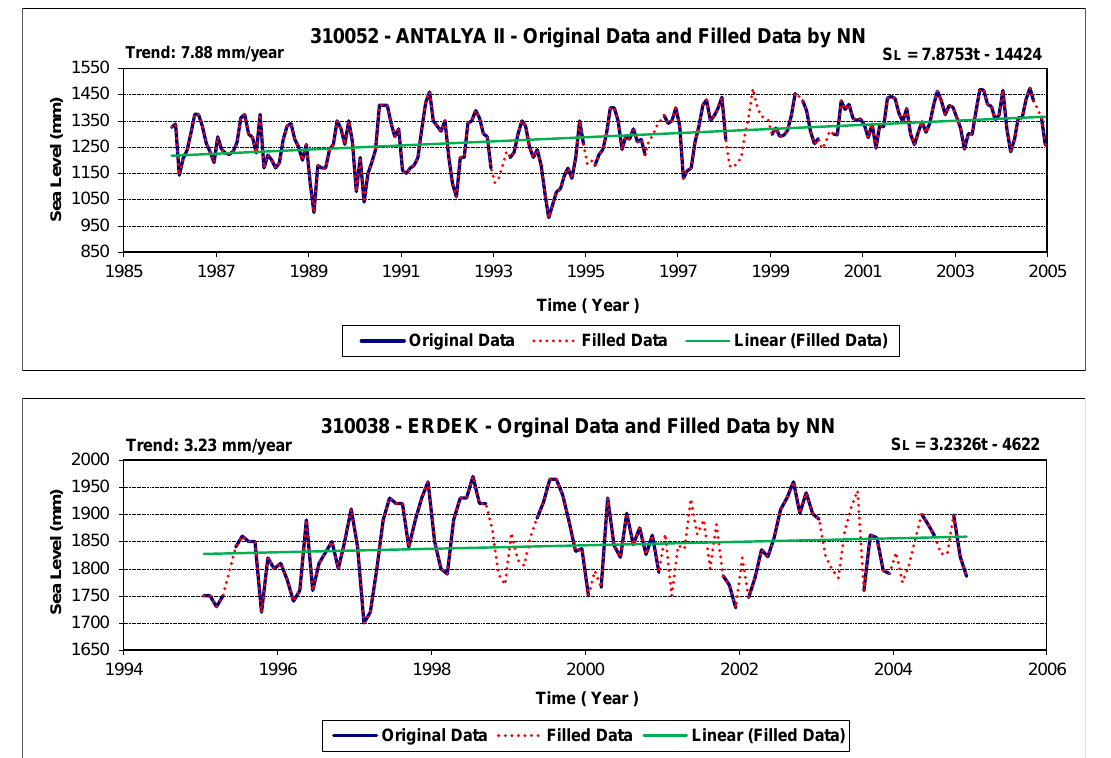
Figure 9. Time series of Antalya-II and Erdek tide gauges by fill by MLFB-NN method.